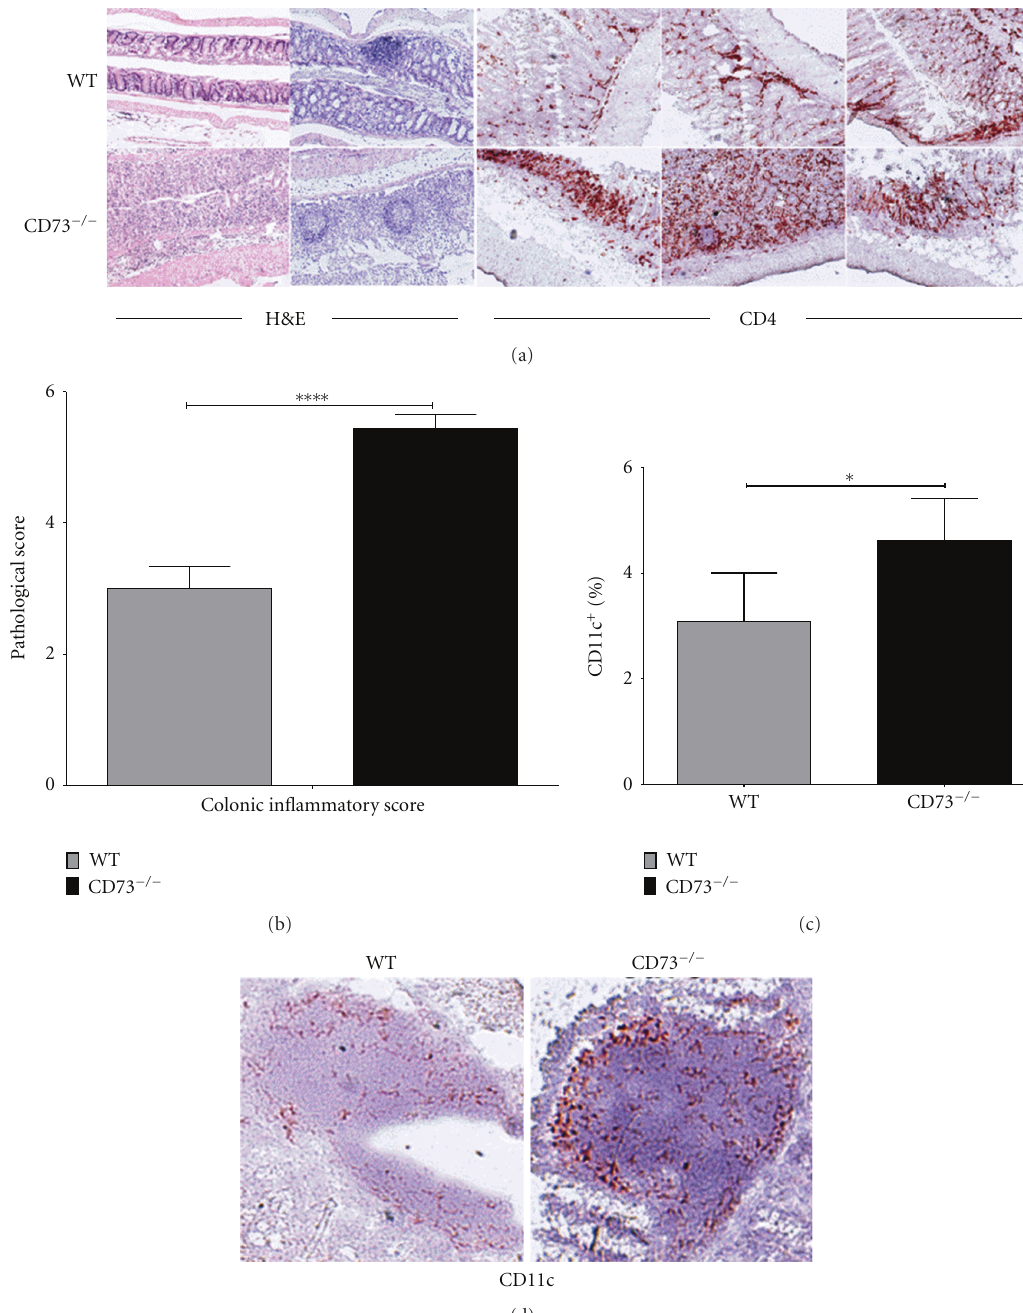
Figure 2: CD73 − / − mice display a higher degree of infiltration in the colon compared to WT mice. of the bowel wall = 3). The two scores (cell infiltration and infiltration in the colons of mice. (e) IL-1 β and TNF- α cell damage) are added, and the combined histological colitis produced by lymphocytes from colonic patches of CD73 − / − and WT mice after 24-hour incubation in medium without severity score ranges from 0 to 6. (c) Colonic patches from stimulation. Samples were analyzed by Bio-Plex instrument WT and CD73 − / − mice treated with 3% DSS in drinking water were isolated and stained for CD11c and analyzed (from three di ff erent experiments, n = 15 mice, ∗ P < 0 . 05, ∗∗ P < 0 . 01, ∗∗∗ P < 0 . 005, ND = not detected). by FACS. Results are displayed as % of CD11c + cells (data representative of 3 experiments). (d) Immunohistochemistry In Figure 3, (a) CD4 + CD45RB high T cells from WT (circles) and CD73 − / − (squares) were transferred into of colons from WT (left) and CD73 − / − (right) mice treated with 3% DSS in drinking water. Sections show CD11c rag − / − mice, which were monitored for 45 days.